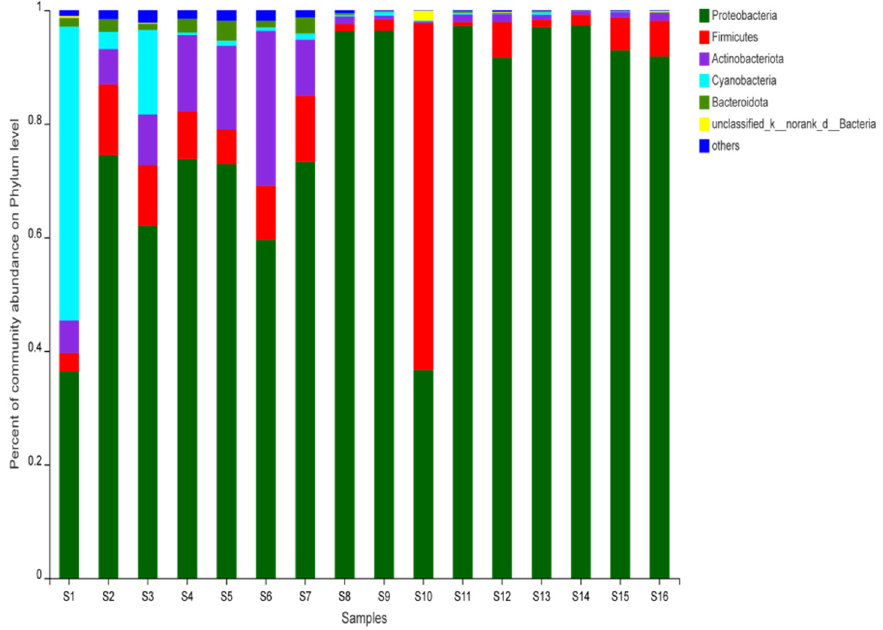
Figure 2. Relative abundance of bacteria at the phylum level in the samples.